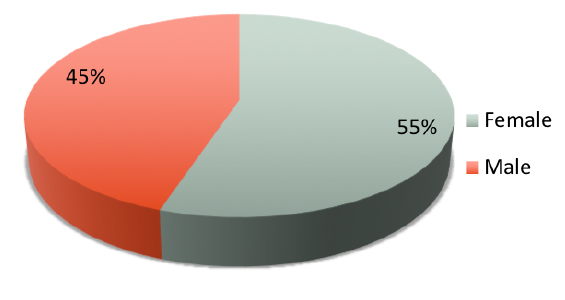
Fig. 2 . Gender distribution of Fellows over three